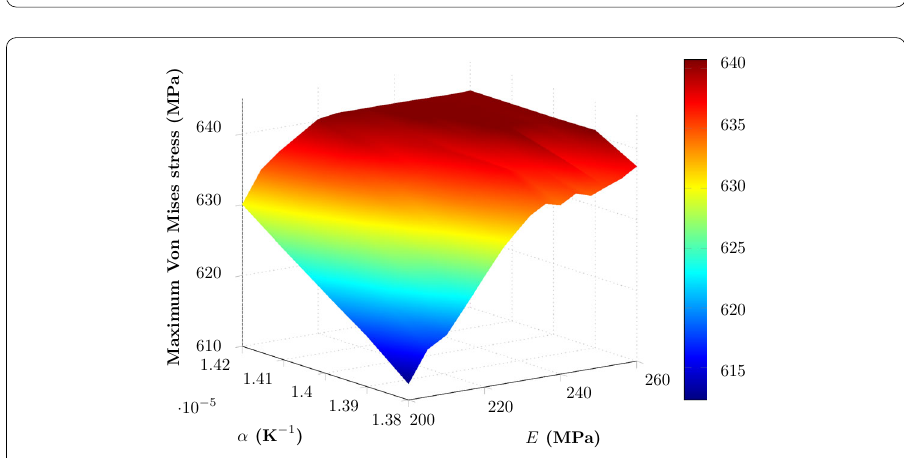
Fig. 6 Von Mises stress map [MPa] with the LATIN-PGD method (left) and deviation from the reference in percent [%] (right)